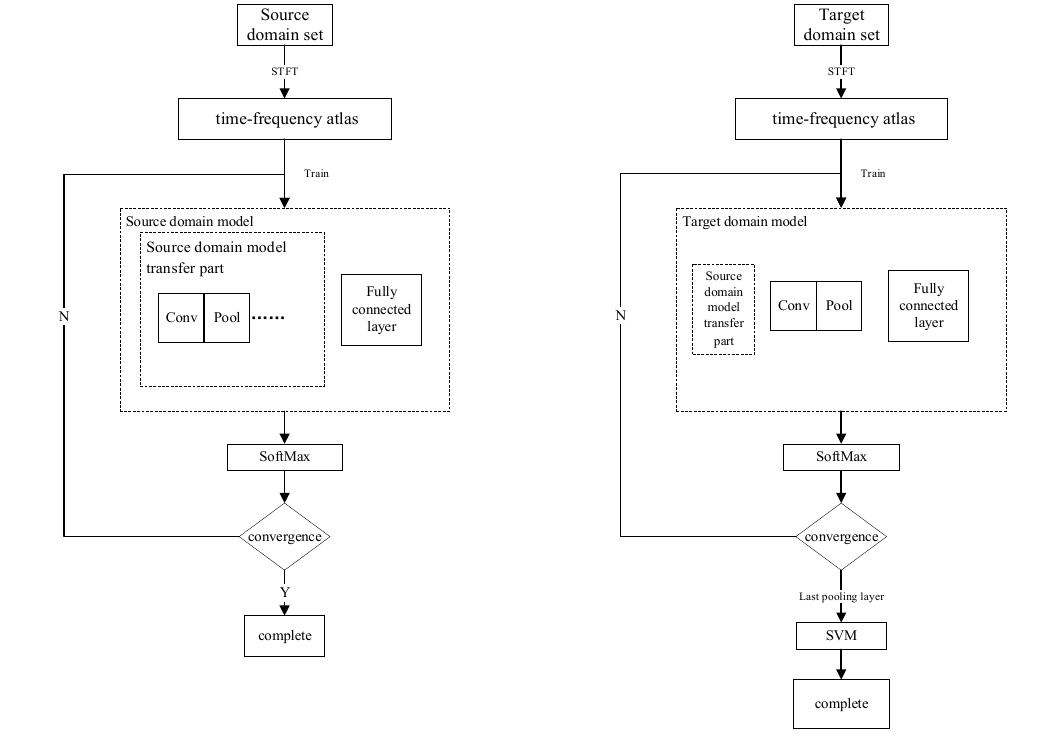
Figure 3. FFCNN-SVM model fault diagnosis flowchart.